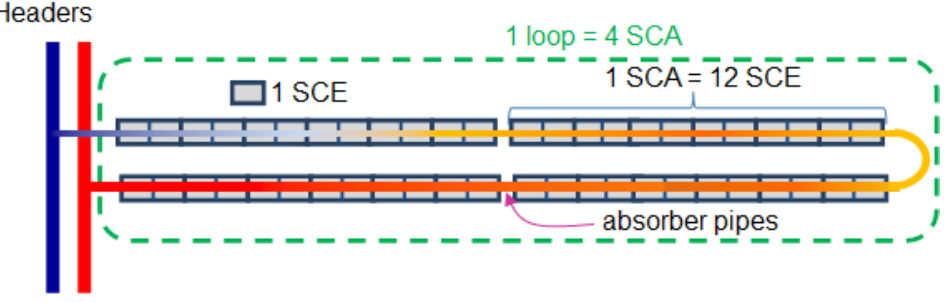
Figure 4. U ‐ Shaped loop in PTC solar plants.